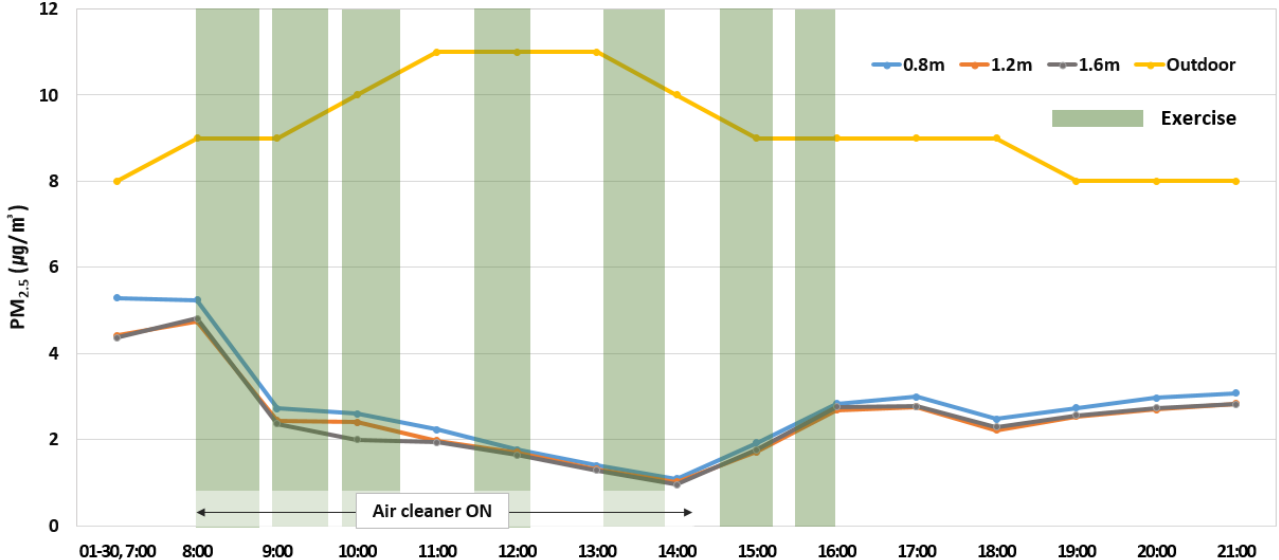
Figure 4. Measurement of ultrafine-dust (PM2.5) concentration in the MPA-space of D elementary school on 30 January 2020 as a function of the physical activities. Table 4. Activity schedule of the MPA-space of D elementary school on 30 January 2020. Number of Time Activity Type Air